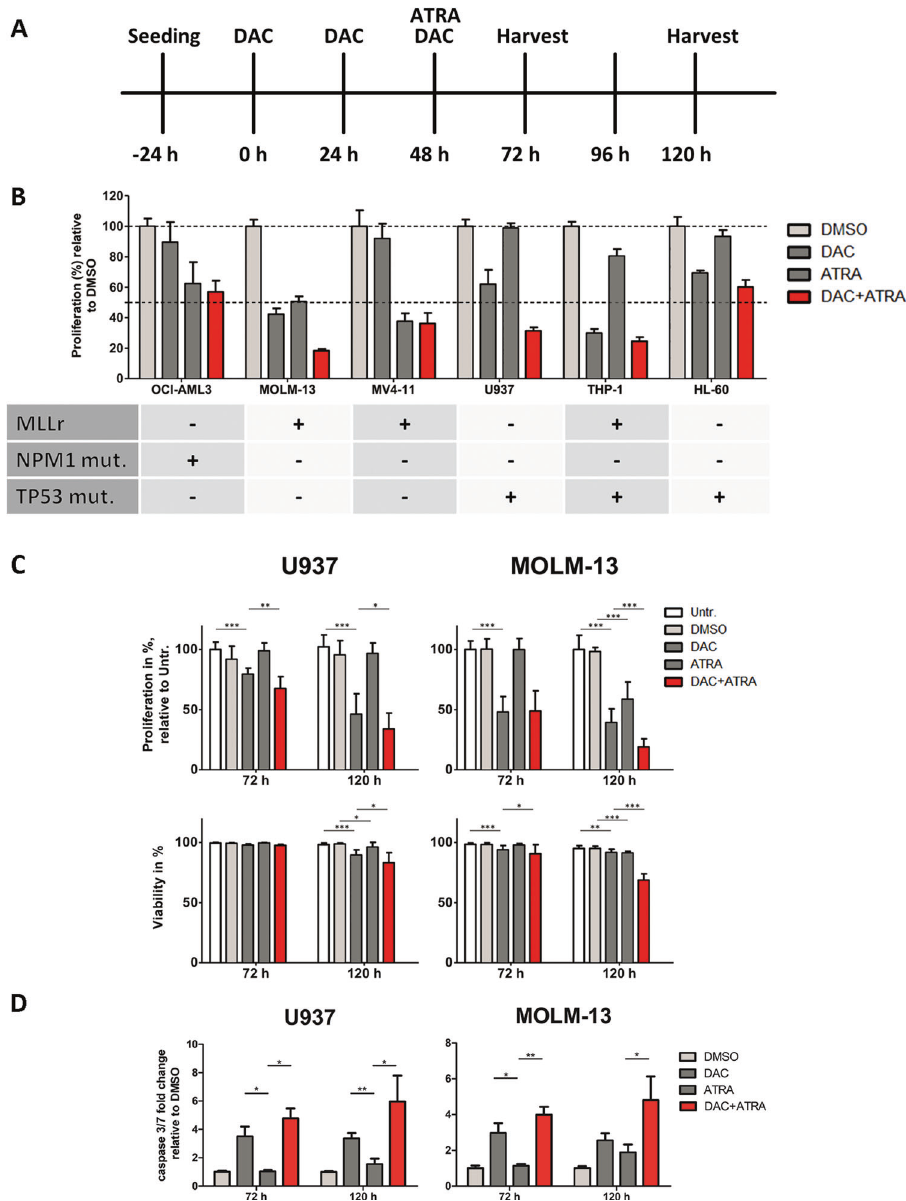
Fig. 1 Decitabine and all- trans retinoic acid exhibit cooperative effects on inhibition of proliferation and reduction of viability in AML cell lines. A Treatment scheme. B Baseline-corrected proliferation of OCI-AML3, MOLM-13, MV4-11, U937, THP1, and HL-60 cells treated with DAC (100 nM) and ATRA (1 µM) after 120 h. Experiments were conducted in technical triplicates. C Proliferation and viability of U937 and MOLM-13 cells were measured 72 and 120 h after the fi rst dose of Decitabine, untreated or treated with DMSO, DAC (U937: 200 nM; MOLM-13: 100 nM), ATRA (1 µM) or DAC + ATRA in combination. Three independent experiments, each with three independent technical replicates, were conducted. Standard deviation is shown as error bars. D Caspase-3/7 activity in U937 (left panel) and MOLM-13 cells (right panel) displayed as fold-change relative to a DMSO-treated control at 72 and 120 h. Six (72 h) and nine (120 h) independent experiments, each with three independent technical replicates, were conducted, respectively. Standard deviation is shown as error bars. Statistical signi fi cance was tested for by unpaired t -test with a threshold of p <